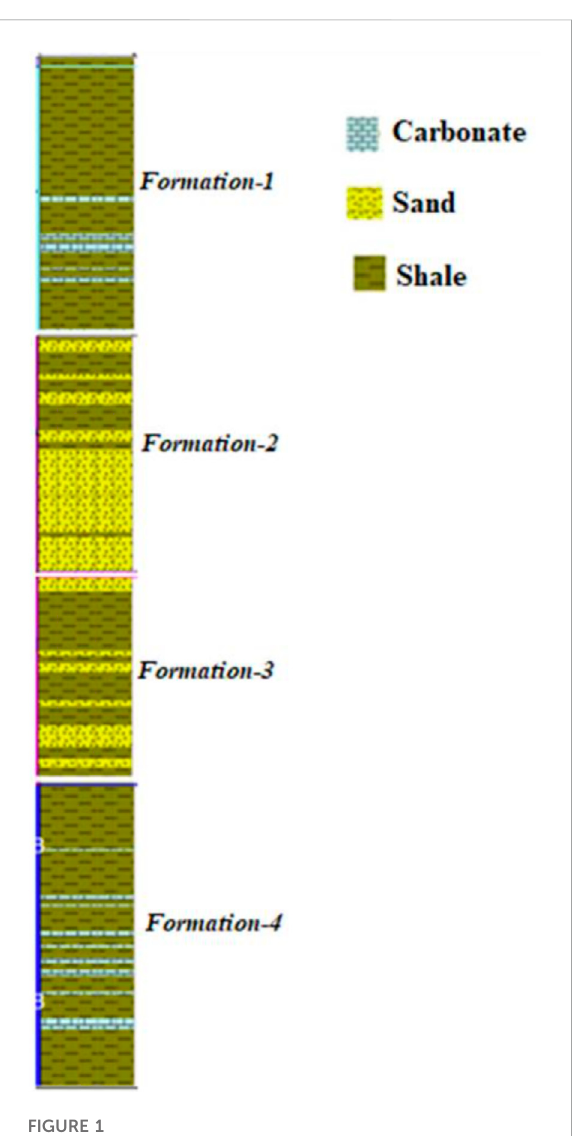
FIGURE 1 Lithology column for Well-A.